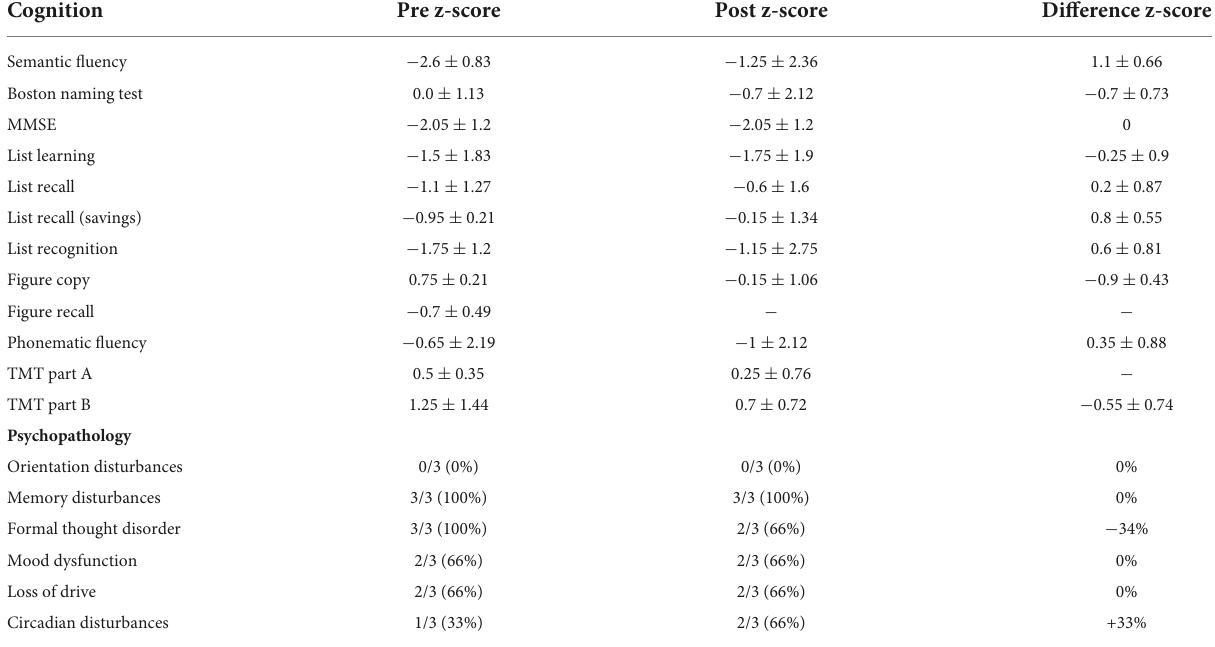
TABLE 2C Neuropsychological and psychometric data in patients with mild cognitive impairment.